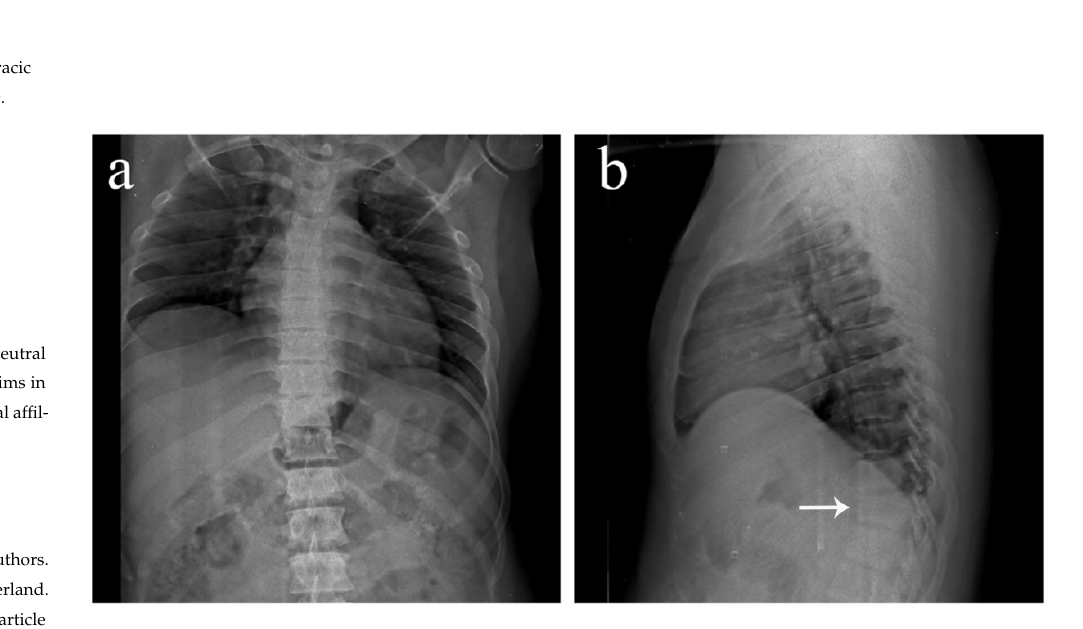
Figure 1. Antero-posterior and lateral view plain radiographs of a 35-year-old male who was brought to the emergency department with multiple abrasions over the trunk and pain in the upper back following a motor vehicle accident. He was conscious and well oriented with stable vitals. Upon examination, midline tenderness was elicited throughout his upper back. His motor power was 5/5 in all four limbs, and there was no sensory deficit. Plain radiographs revealed an obvious anterior wedge compression fracture of the T11 thoracic vertebra. However, since tenderness was elicited throughout the upper thoracic spine and not confined just to the T11 level, more fractures were suspected. On further examination of the anteroposterior view radiograph, it was noticed that the spinous process shadows of the upper thoracic vertebra were either absent or deviated. This brought suspicion of multiple spinous process fractures, which were later confirmed using a com- puted tomography (CT) scan. ( a ) Antero-posterior view of the thoracic spine showing absent or deviated spinous process shadows throughout the upper thoracic spine, raising suspicion of spi- nous process fractures. ( b ) Lateral view of the thoracic spine showing a compression fracture of T11 vertebrae (arrow). ( c ) Antero-posterior view of the lumbar spine where the T11 vertebra appears to be sclerotic (arrow). ( d ) Lateral view of the lumbar spine showing normal lordosis and the T11 com- pression fracture (arrow).